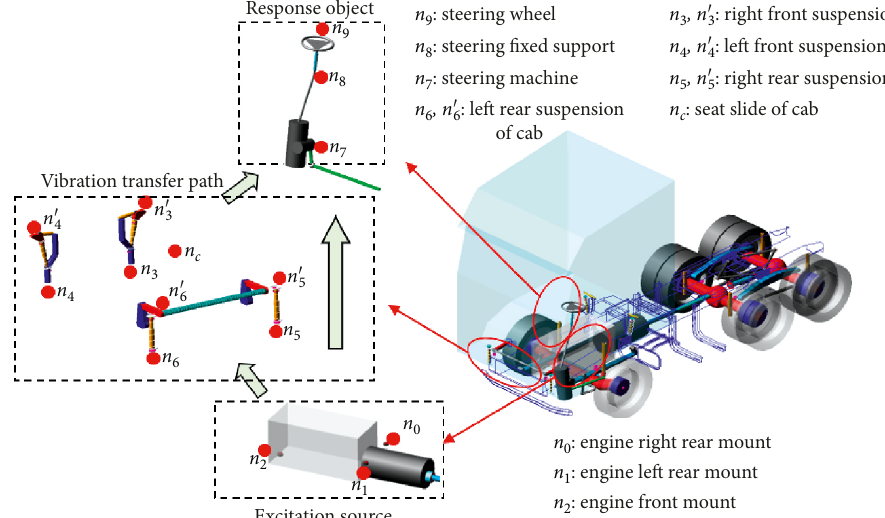
Figure 4: Node system division based on the vibration transfer path of the steering system.